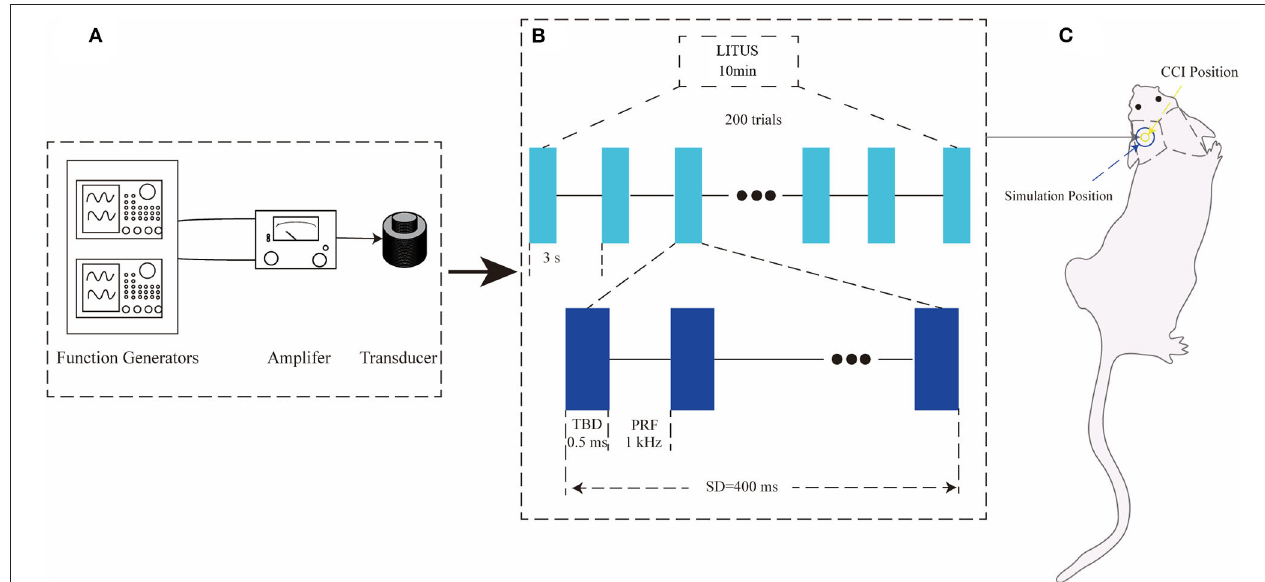
FIGURE 1 | (A) LITUS system, two connected function generators were used to generate pulsed signals. The pulsed signal from the second generator was amplified by a linear power amplifier and transmitted to an unfocused ultrasound transducer. (B) The time schedule of ultrasound stimulation and the parameters of the ultrasound. The total stimulation duration was 10min with 200 trials. The ultrasound FF and PRF were 500 and 1kHz, respectively. The ultrasound SD and TBD were 400 and 0.5ms, and the I sppa value was 2.6 W/cm 2 the time schedule of each group. (C) Ultrasonic stimulation was applied to the local area of CCI with a diameter of about